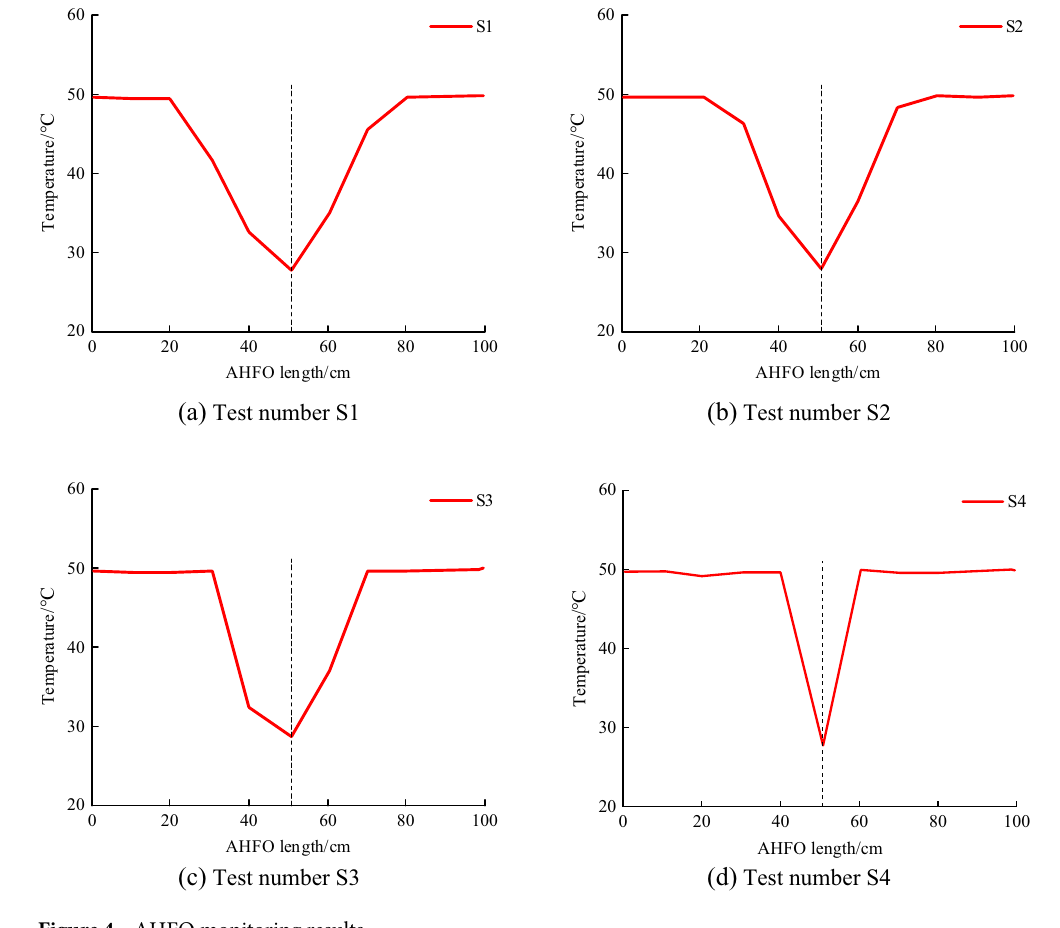
Figure 4. AHFO monitoring results.